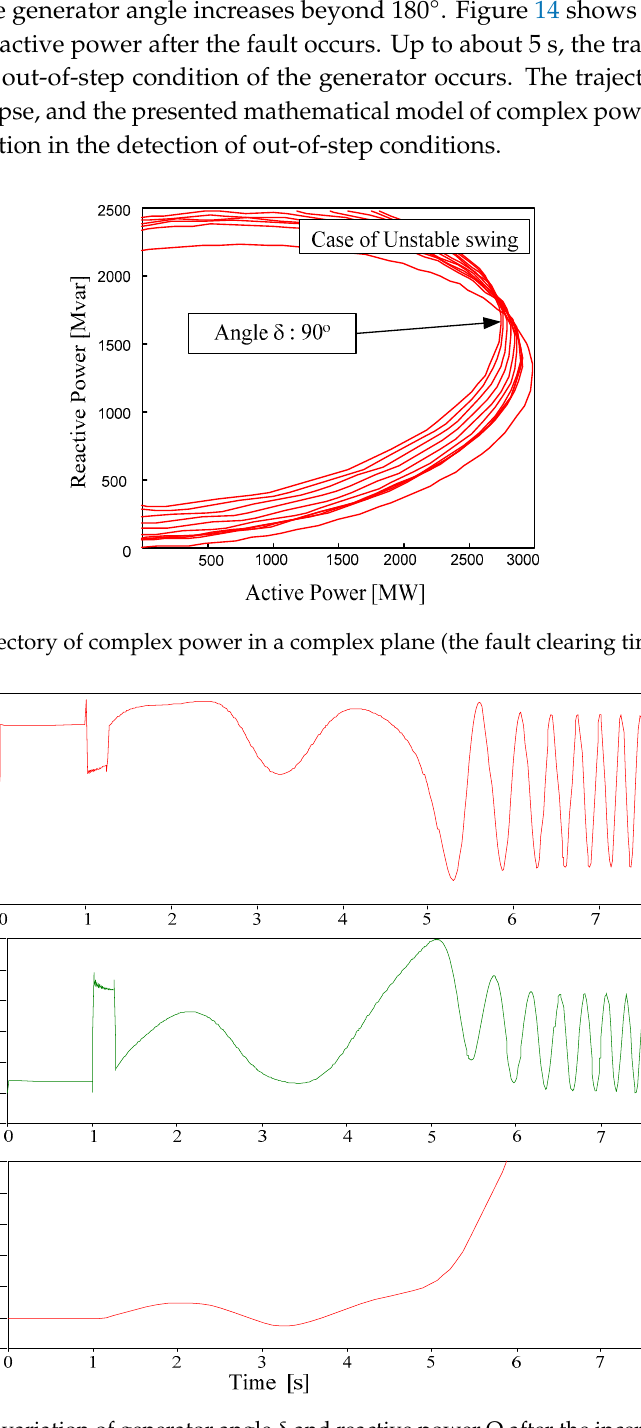
Figure 12. The time variation of generator angle δ and reactive power Q after the inception of the fault.